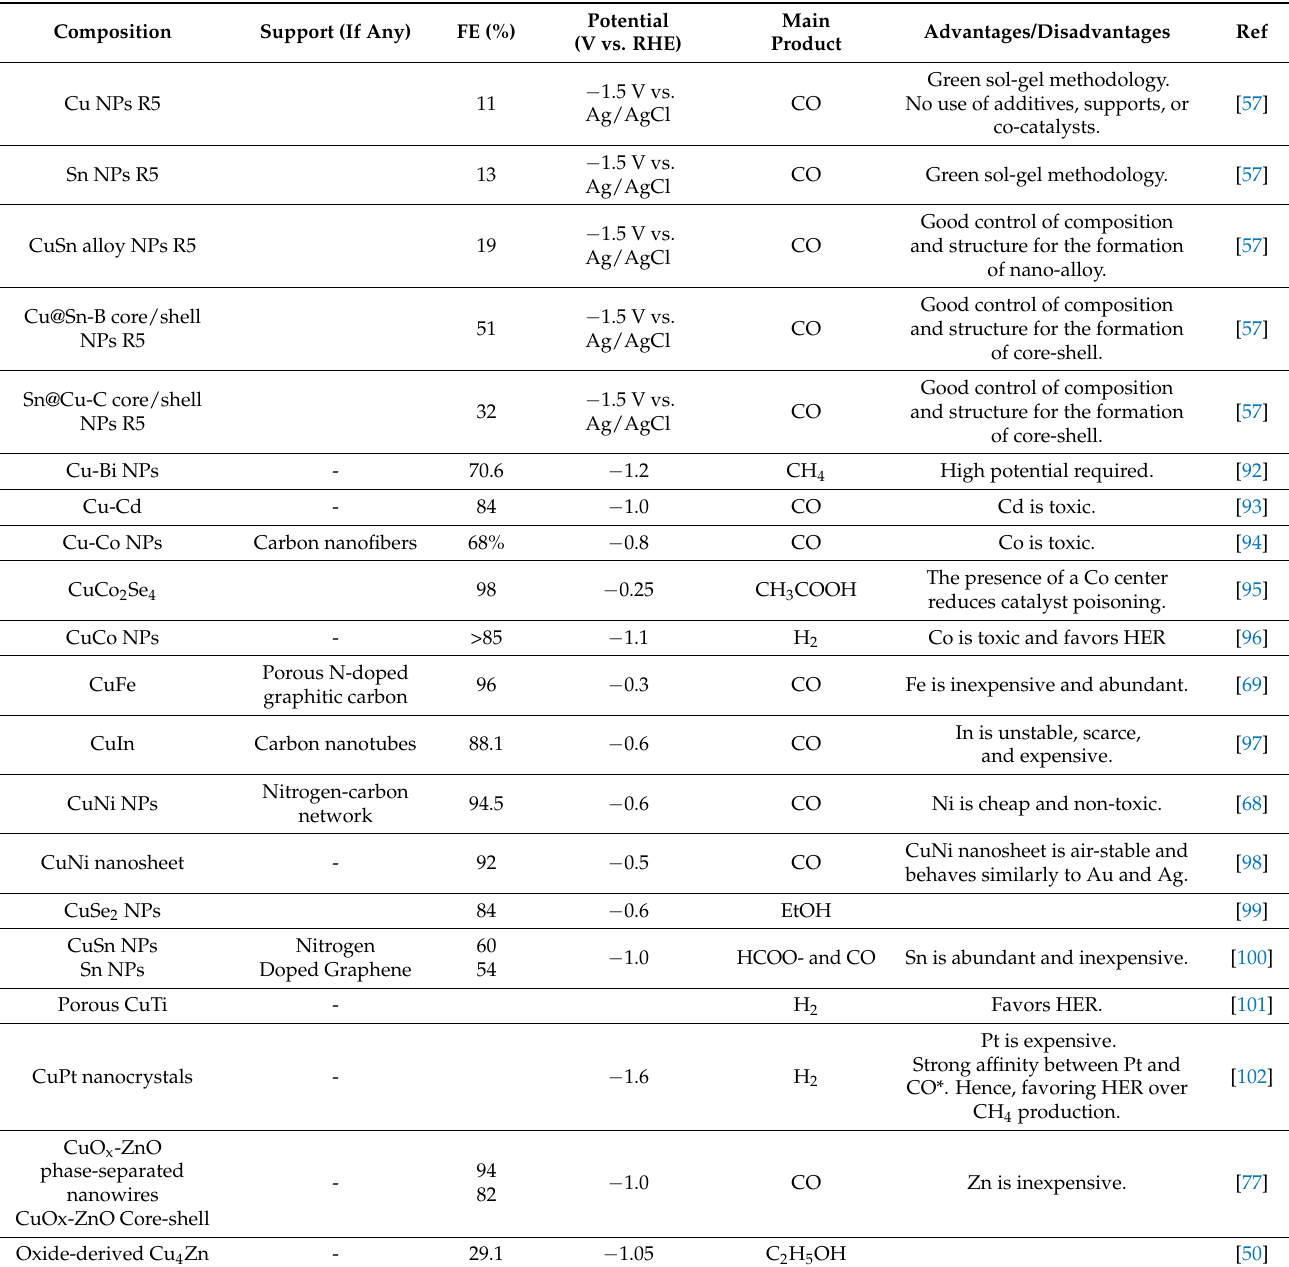
Table 6. The various Cu-based nanocatalysts used for CO 2